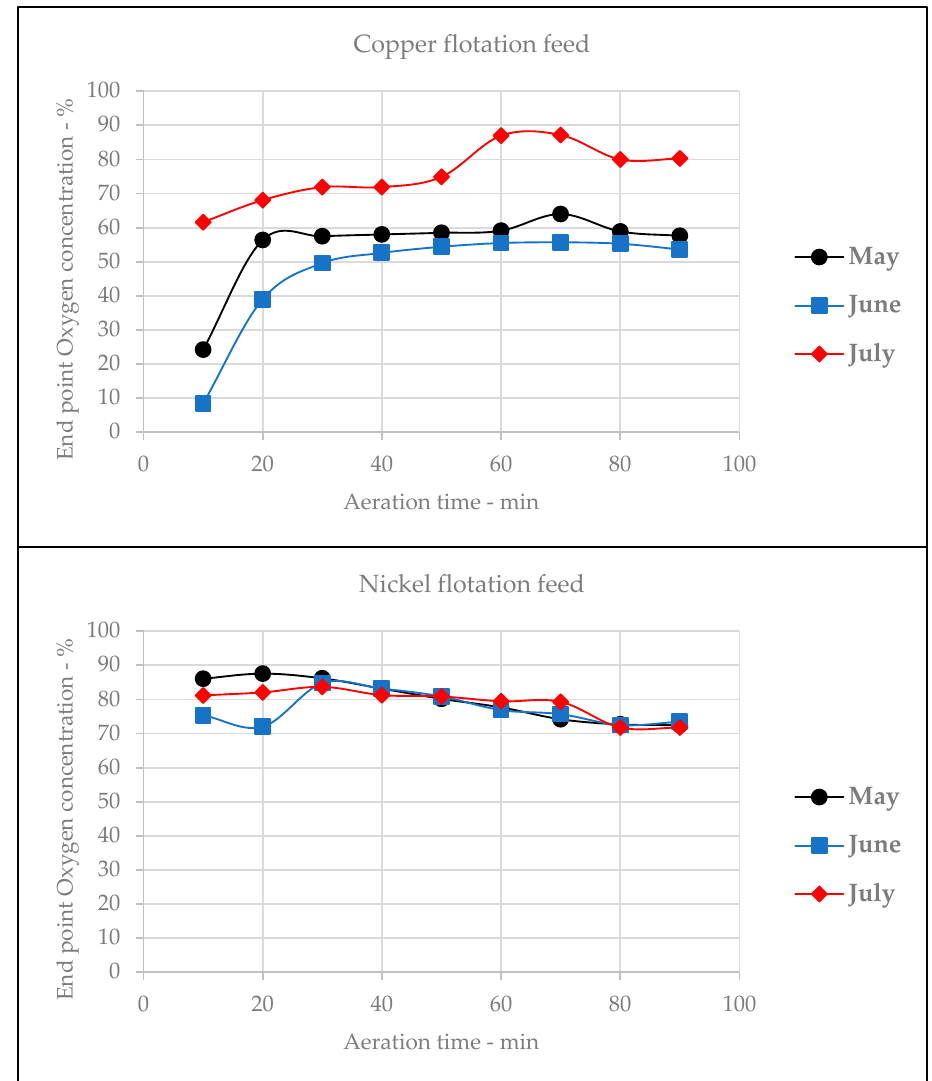
Figure 6. Dissolved oxygen endpoint for copper and flotation feed for different months.